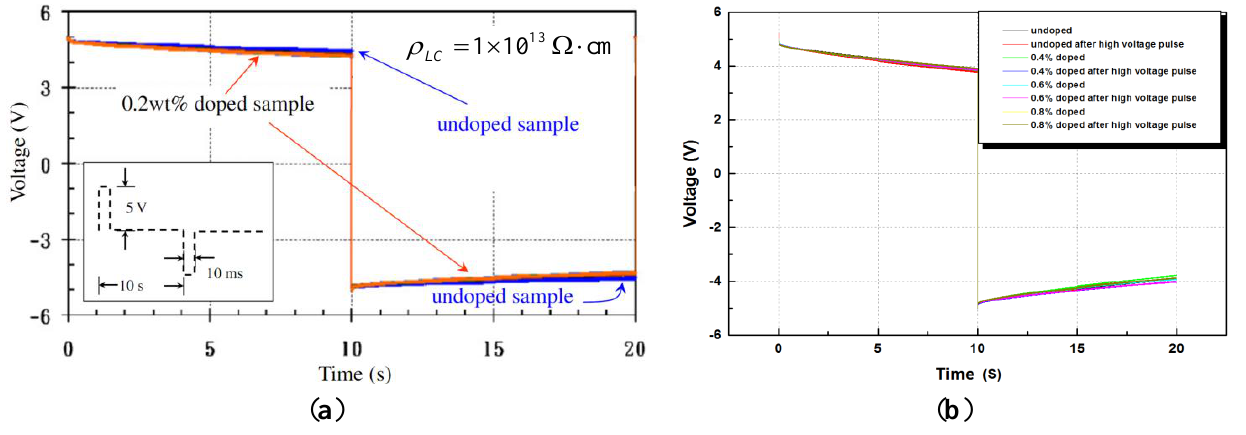
Figure 10. VHR waveforms for LCs of different resistivities and ITO concentrations: ( a ) an undoped LC cell and an ITO-doped cell of 0.2 wt % with LC of 1 × 10 13 Ω∙cm. The excitation waveform is given in the lower left inset; ( b ) VHR waveforms for LC of 1.2 × 10 15 Ω∙cm with several different ITO